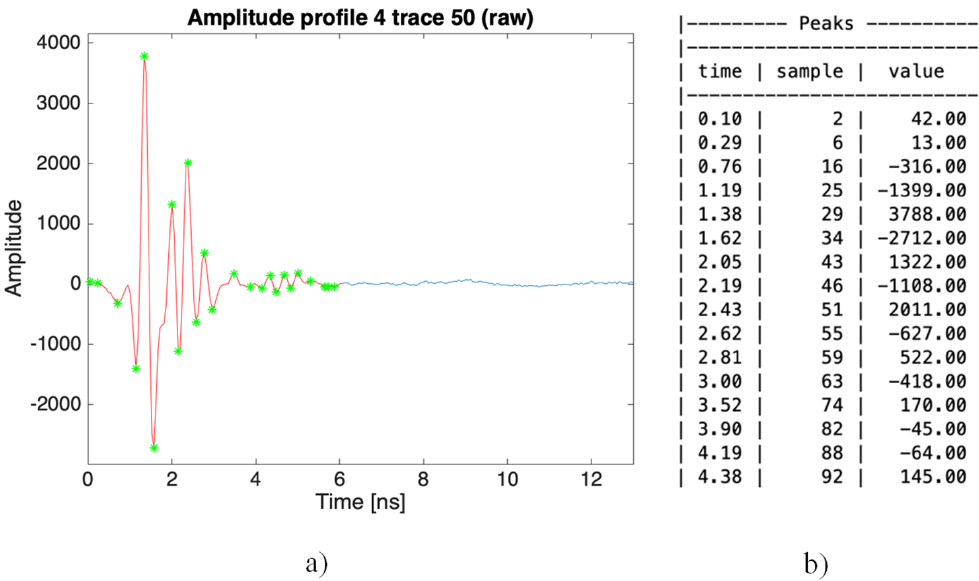
Figure 4. ( a ) Trace plot where range 0–6 ns has been highlighted in red and peaks marked in green; ( b ) table showing the information (travel-time distance, sample number, sample value, amplitude) related to some of the peaks in the plot.